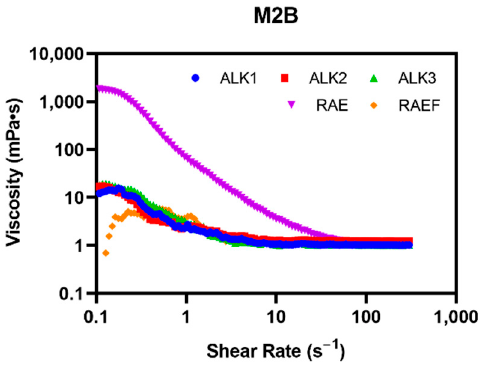
Figure 7. Peptides were prepared via incubation in PBS. Samples were examined at shear rates from 1–300 Hz and viscosity plotted using Rheocompass.